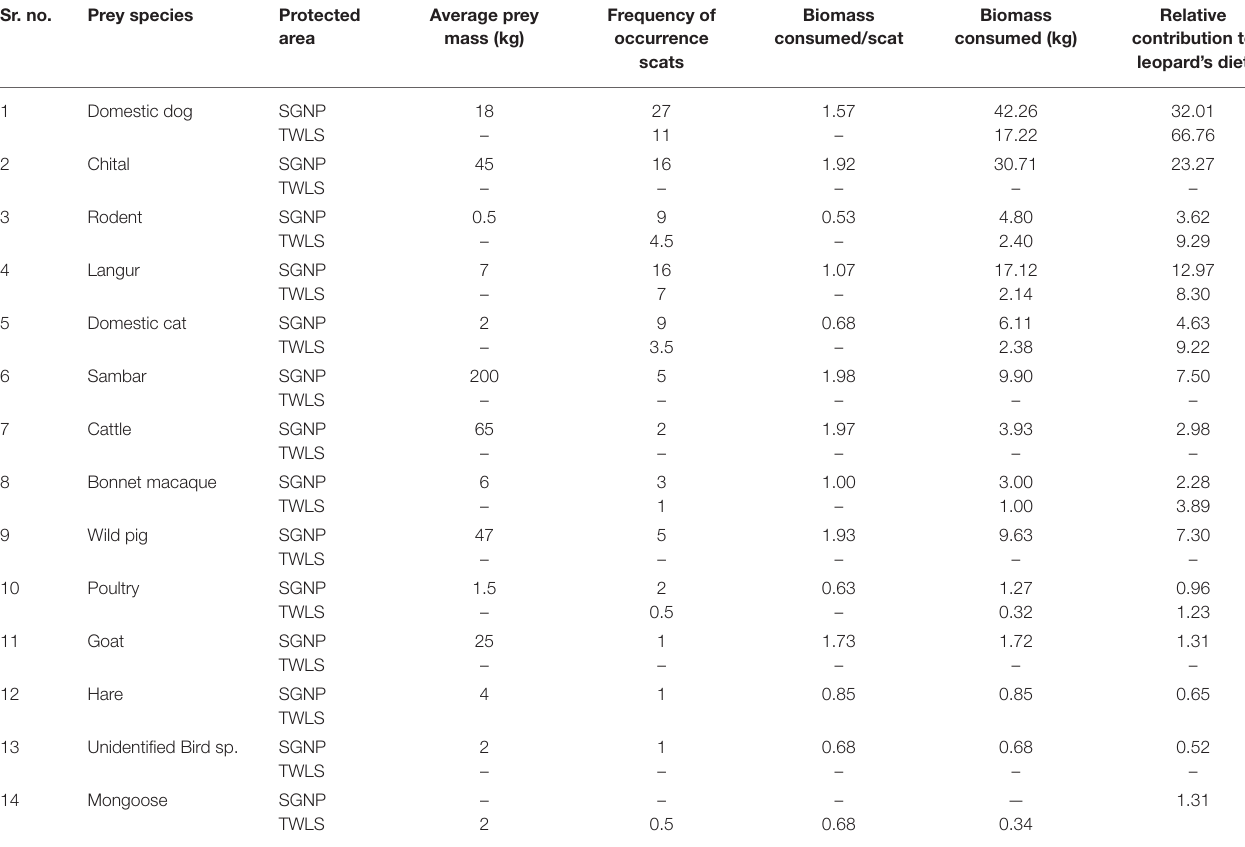
TABLE 5 | Frequency of prey species found in leopard’s scats, biomass consumed and relative contribution of each prey consumed in the study area of Sanjay Gandhi National Park ( n = 97) in 2015 and Tungareshwar Wildlfie Sanctuary ( n = 23) in 2016. Sr.